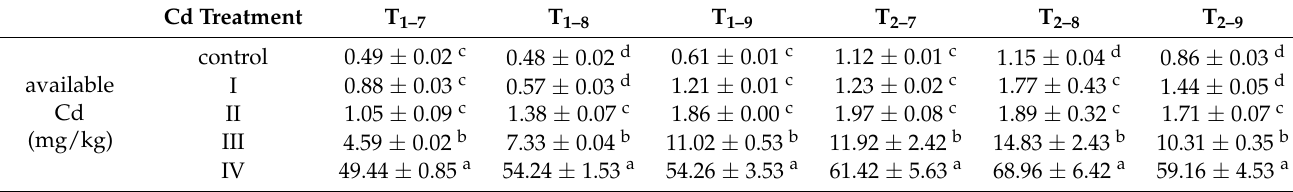
Table 1. Available Cd content of soil under Cd treatment control, I, II, III and IV). Cd